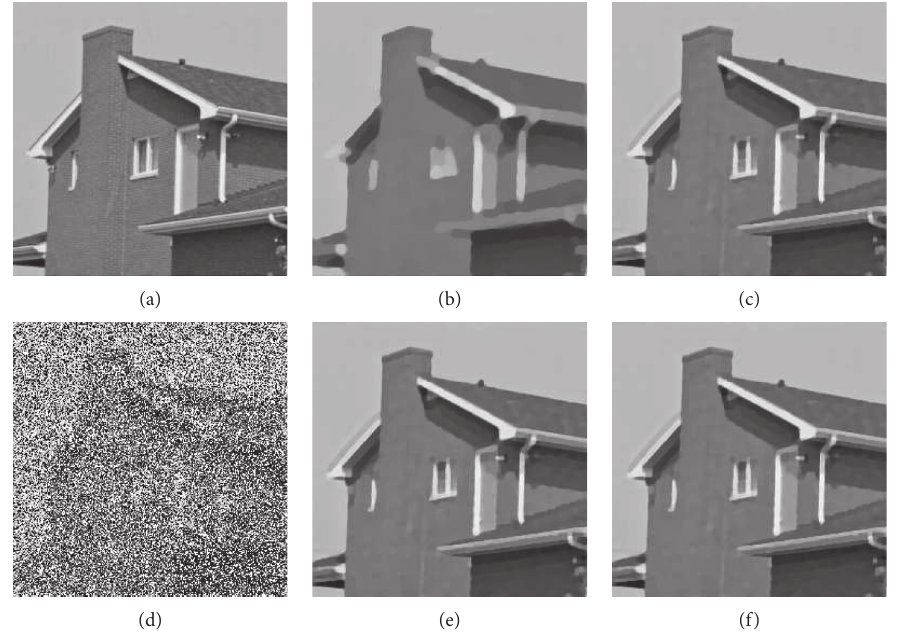
Figure 4: The recovery results (House 256) by Average blur with 60% SP noise. (a) Original. (b) TVL1, PSNR � 24.5554. (c) TVSCAD, PSNR � 30.4234. (d) Average blur (lev � 0.6). (e) TVLog, PSNR � 30.3966. (f) LogTVSCAD, PSNR � 30.4302.